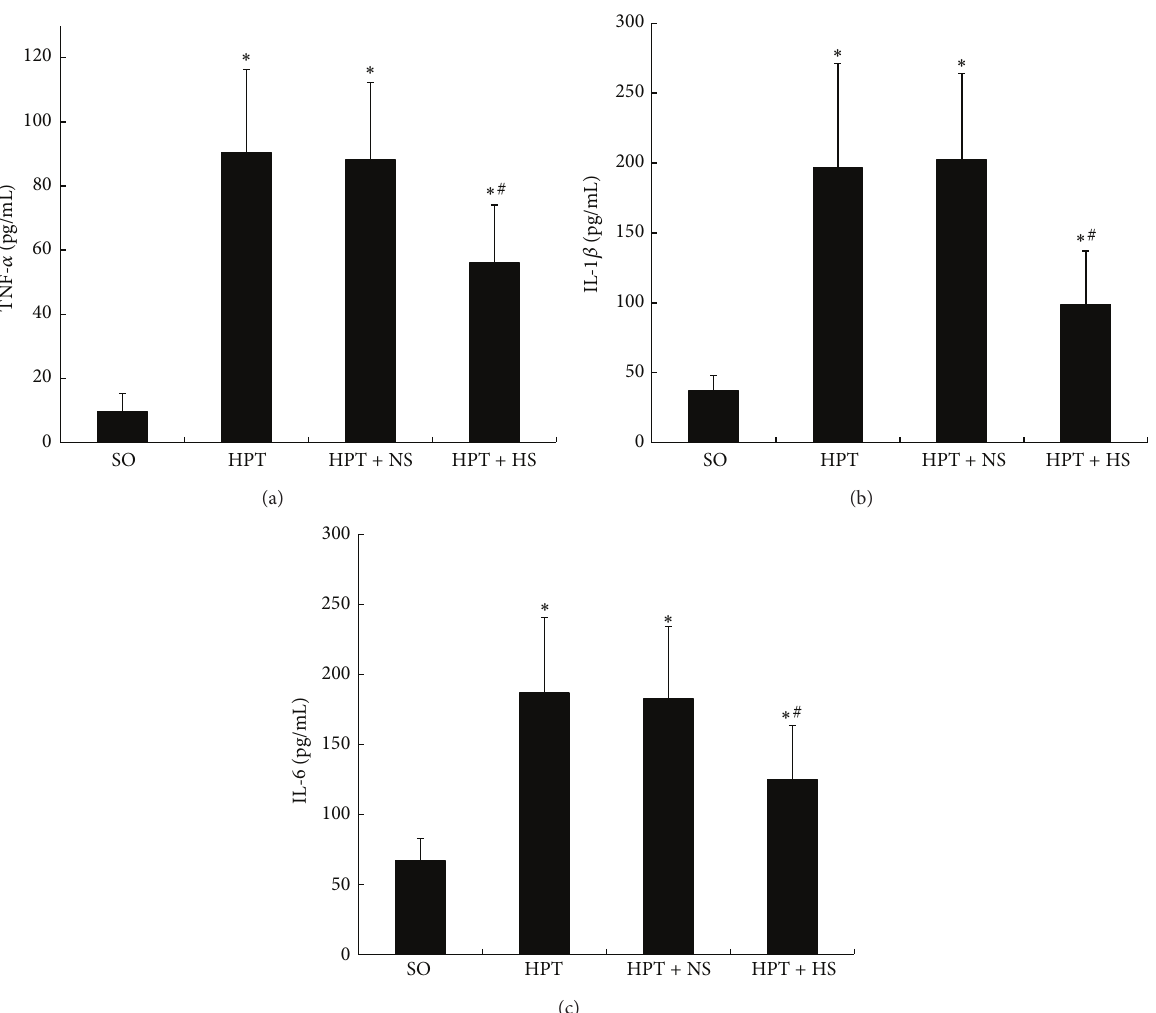
Figure 3: Inhibition of hydrogen-rich saline treatment on serum cytokine levels in rats. The serum TNF- 𝛼 (a), IL-1 𝛽 (b), and IL-6 (c) levels increased strongly after I/R injury. The administration of hydrogen-rich saline (0.6 mM, 6mL/kg) resulted in significantly decreased levels of serum TNF- 𝛼 , IL-1 𝛽 , and IL-6. ∗ 𝑃 < 0.05 compared with the SO group; # 𝑃 < 0.05 , compared with the HPT + NS